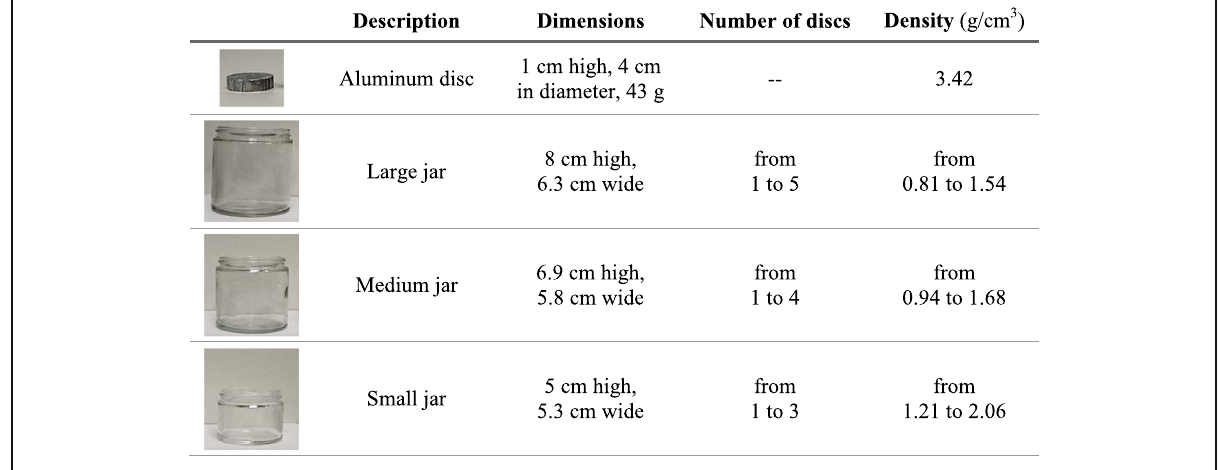
Fig. 4 Specific dimensions of the materials used for the